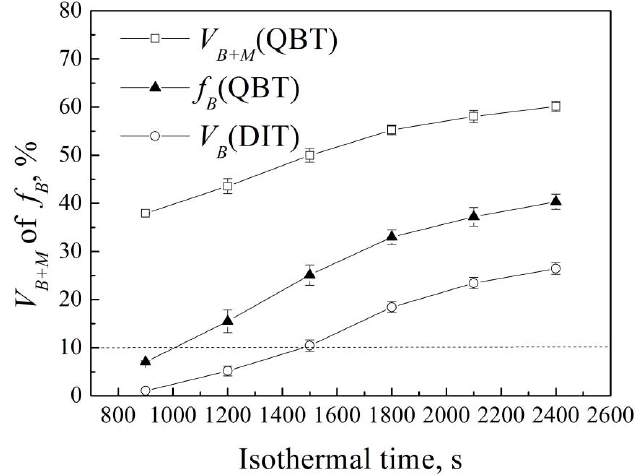
Figure 7. Comparison of the bainite transformation kinetics between DIT and QBT at an isothermal temperature of 300 °C.